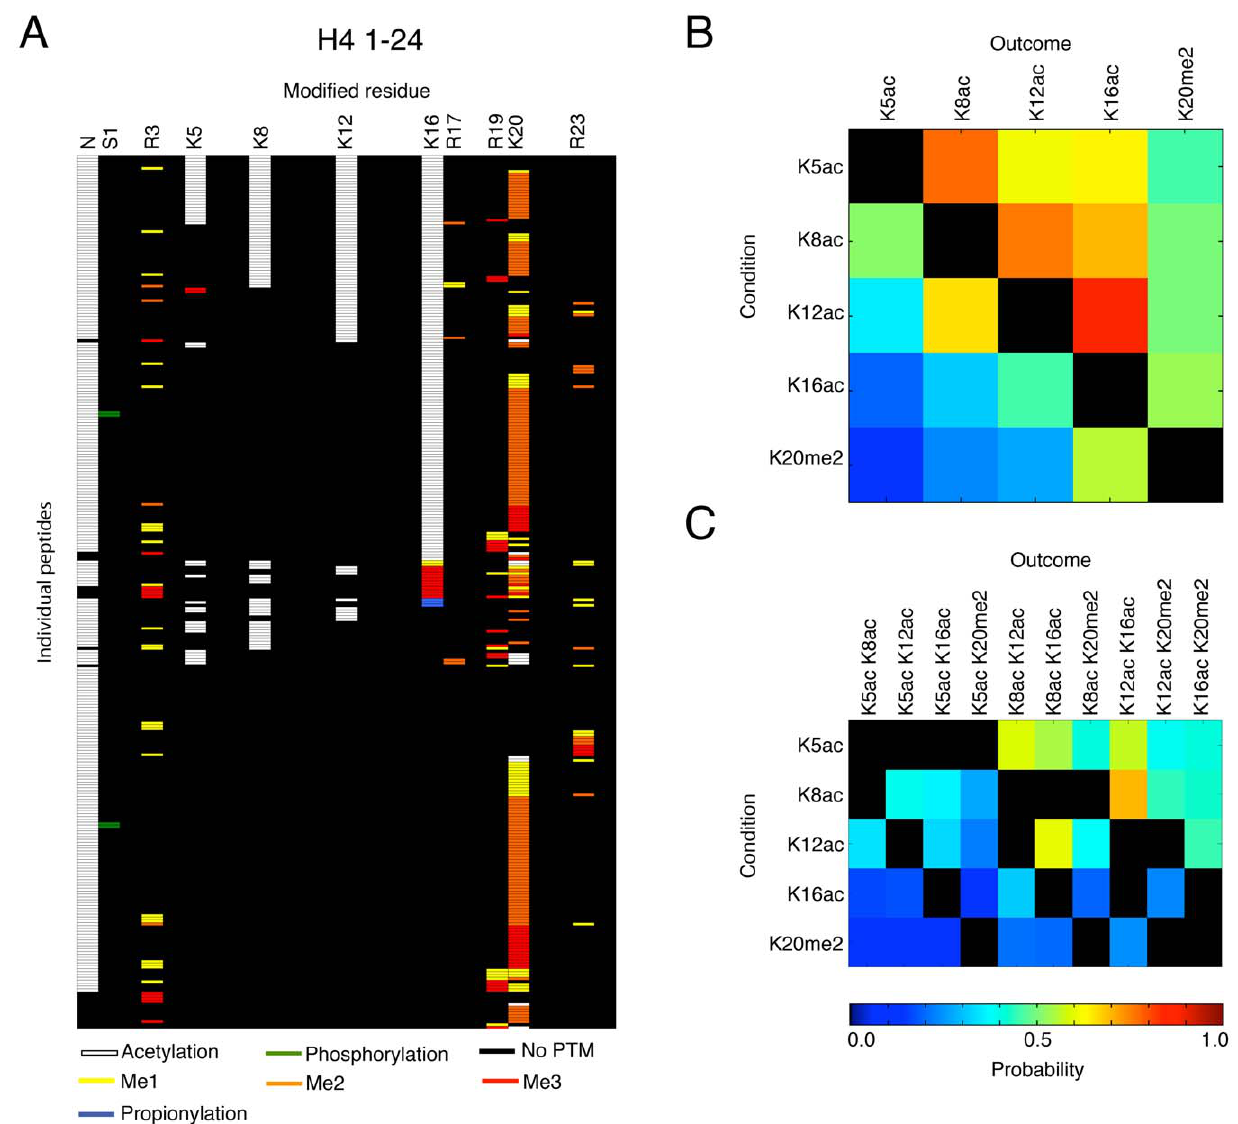
Figure 2. Multiple PTMs occur in distinct combinations on H4. A ) Table depicting each of the 304 combinatorial codes identified on H4 1–24 by ETD-MS. The number of each residue carrying a PTM is indicated at the top and each line represents an individual peptide. Probability of co- occurrence of ( B ) individual PTMs and ( C ) individual PTMs with groups of PTMs, on H4 1–23 determined by an association rule data-mining algorithm. The condition (left rows) is when a specific PTM is observed on H4, and the outcome (top columns) is the probability (indicated by a heat plot) that a second or several PTM(s) are observed at the same time on the same histone molecule.